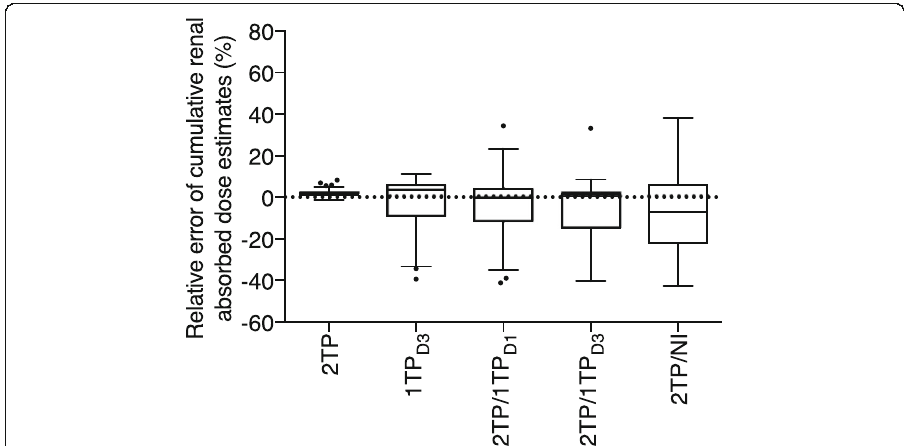
Fig. 4 Comparison of the relative errors of per-induction course cumulative renal absorbed dose estimates obtained by the simplified methods relative to the three-time-point (3TP) method. Boxes represent the interquartile range, and whiskers the interdecile range ( n =